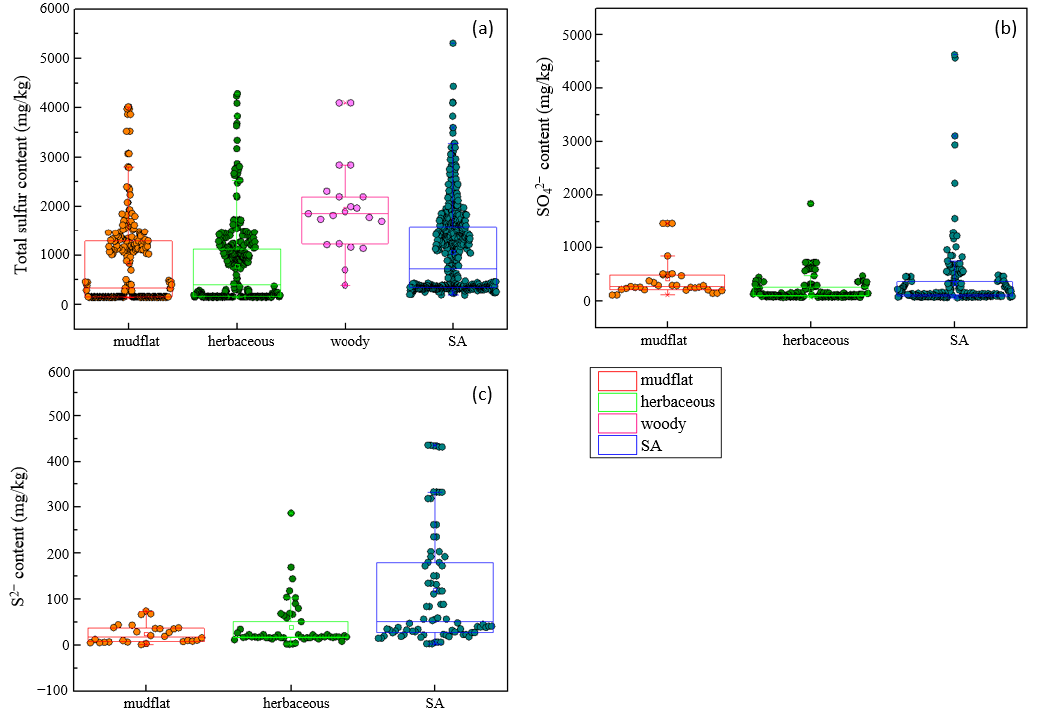
Figure 4. Soil total sulfur contents ( a ), sulfate contents ( b ), and sulfide contents ( c ) in invasive S. alterniflora communities, and three different life forms of native communities.